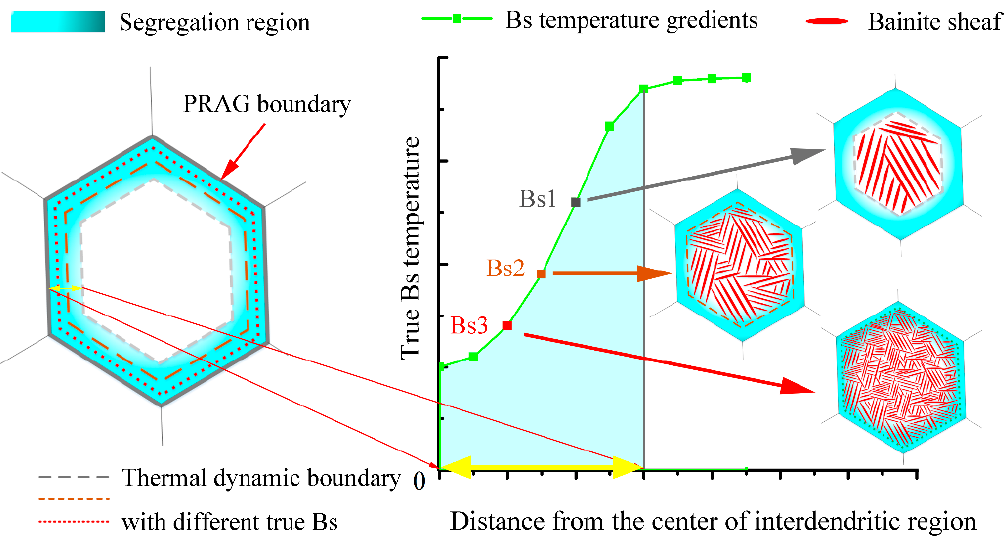
Figure 5. Schematic diagram of the interdendritic segregation effect on bainite and retained austenite distribution under different isothermal temperature (PRAG means the prior austenite grain).